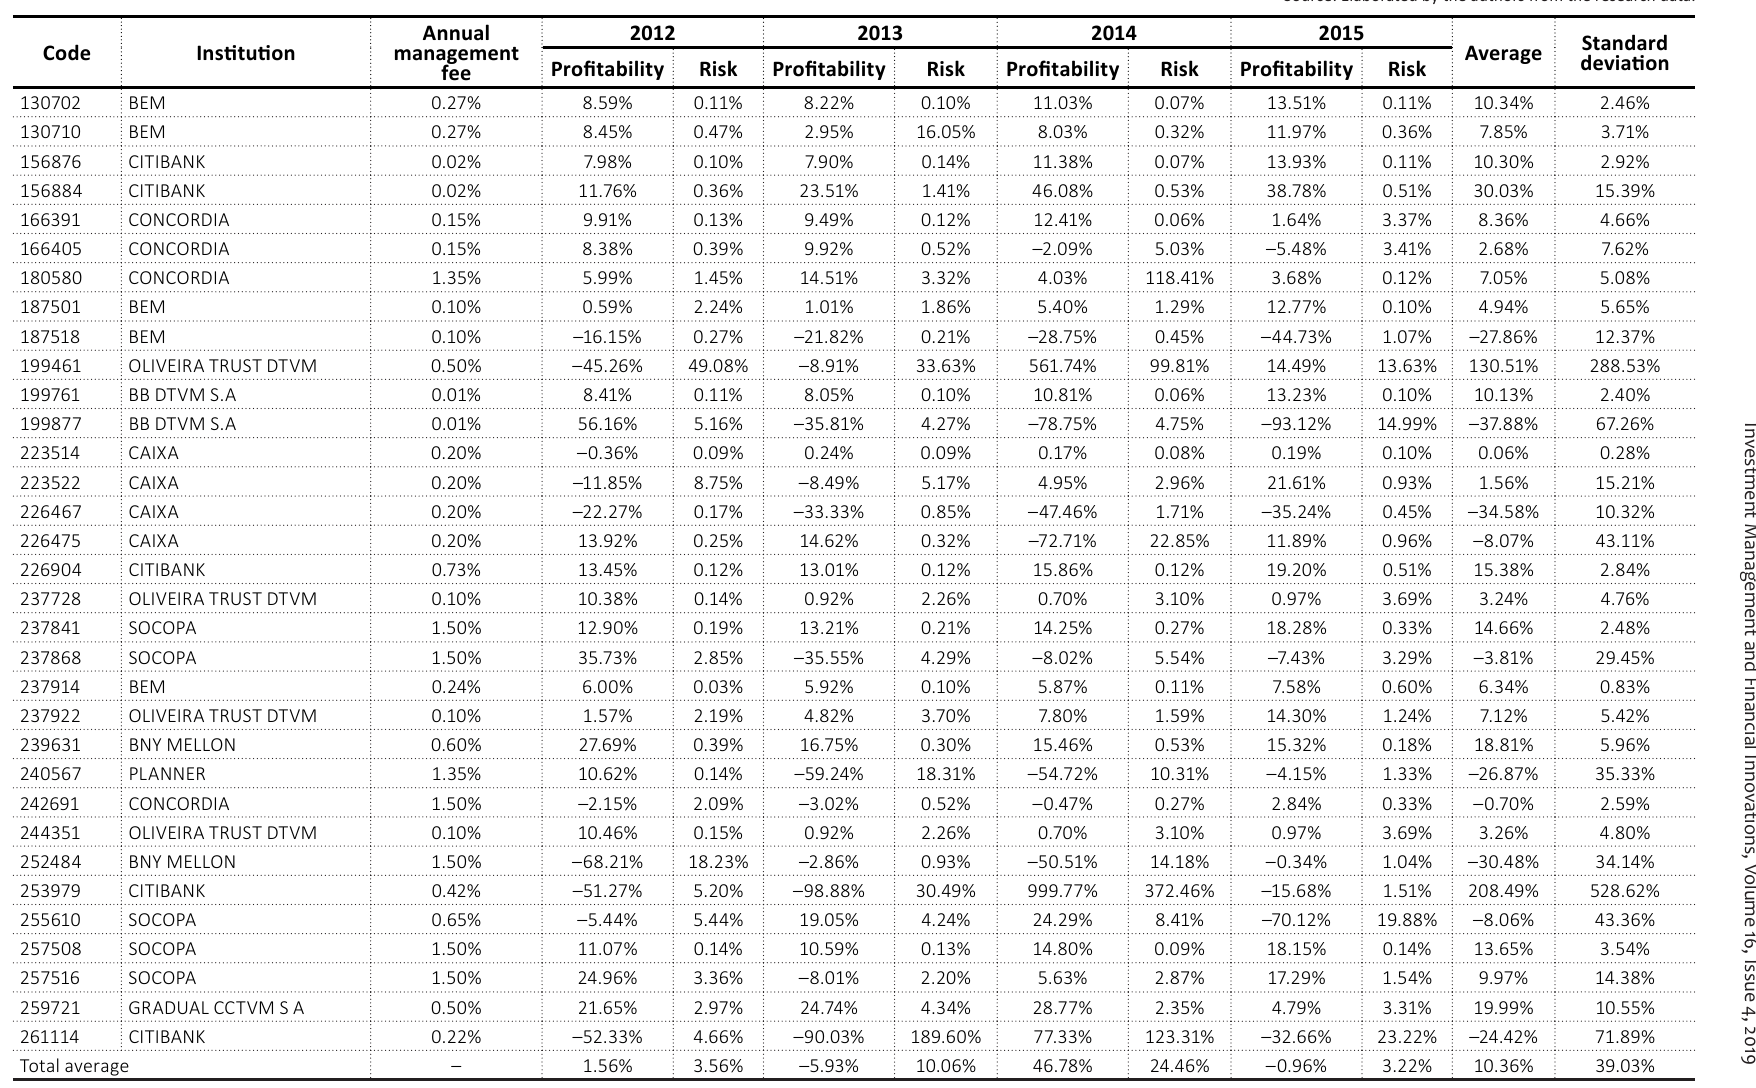
Source: Elaborated by the authors from the research